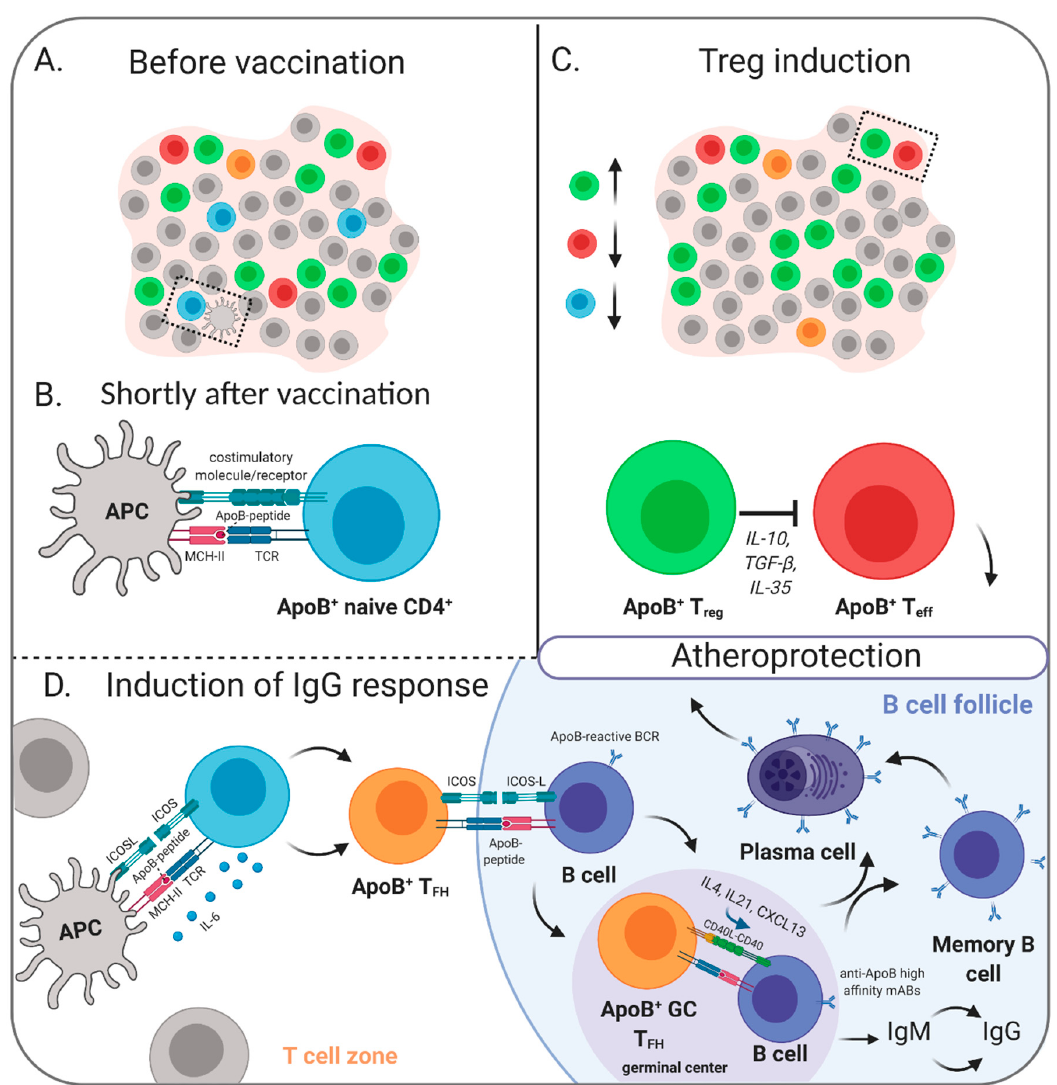
Figure 1. Proposed mechanisms of ApoB-related vaccines. ( A) Before vaccination, naïve and di ff erentiated ApoB-reactive (ApoB + ) CD4 + T cells exist. In healthy individuals, these mainly comprise T regs . ( B ) Shortly after vaccination, antigen-presenting cells (APCs) present ApoB-peptides in MHC-II molecules to cognate naïve CD4 + T cells, which become activated. Activated CD4 + T cells proliferate and di ff erentiate into e ff ector subsets (T e ff ) including regulatory (T regs ) and follicular helper (T FH ) cells. The di ff erentiation is dependent on the cytokine milieu and costimulatory signals. ( C ) T regs confer atheroprotection through various mechanisms including secretion of anti-inflammatory cytokines and inhibition of ApoB + T e ff cells. ( D ) T FH cells aid in di ff erentiation of B cells into plasma cells and memory B cells. Plasma cells produce high-a ffi nity anti-ApoB IgG antibodies that confer atheroprotection via promotion of LDL clearance. Created with